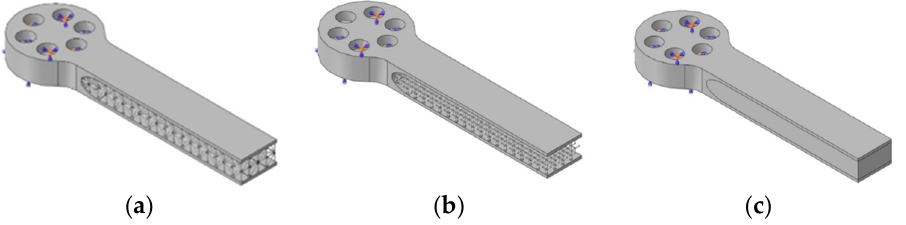
Figure 3. ( a , b ) Discrete model of FCC and Diamond lattice structure. ( c ) Homogenized lattice model. To model the interaction between shaker and specimen, the counterbore and the circular region below the solid are considered to be clamped to ground. A tetrahedral free mesh with 10 nodes quadratic elements (C3D10) is employed to discretize the spatial domain. The concentrated masses were modelled with two reference points kinematically coupled at the tip of the specimen, placed in the center of gravity of the two masses. includes the elastic properties listed in Table 3. Table 3. Homogenized mechanical elastic properties and yield strength of the FCC and Diamond unit cells.